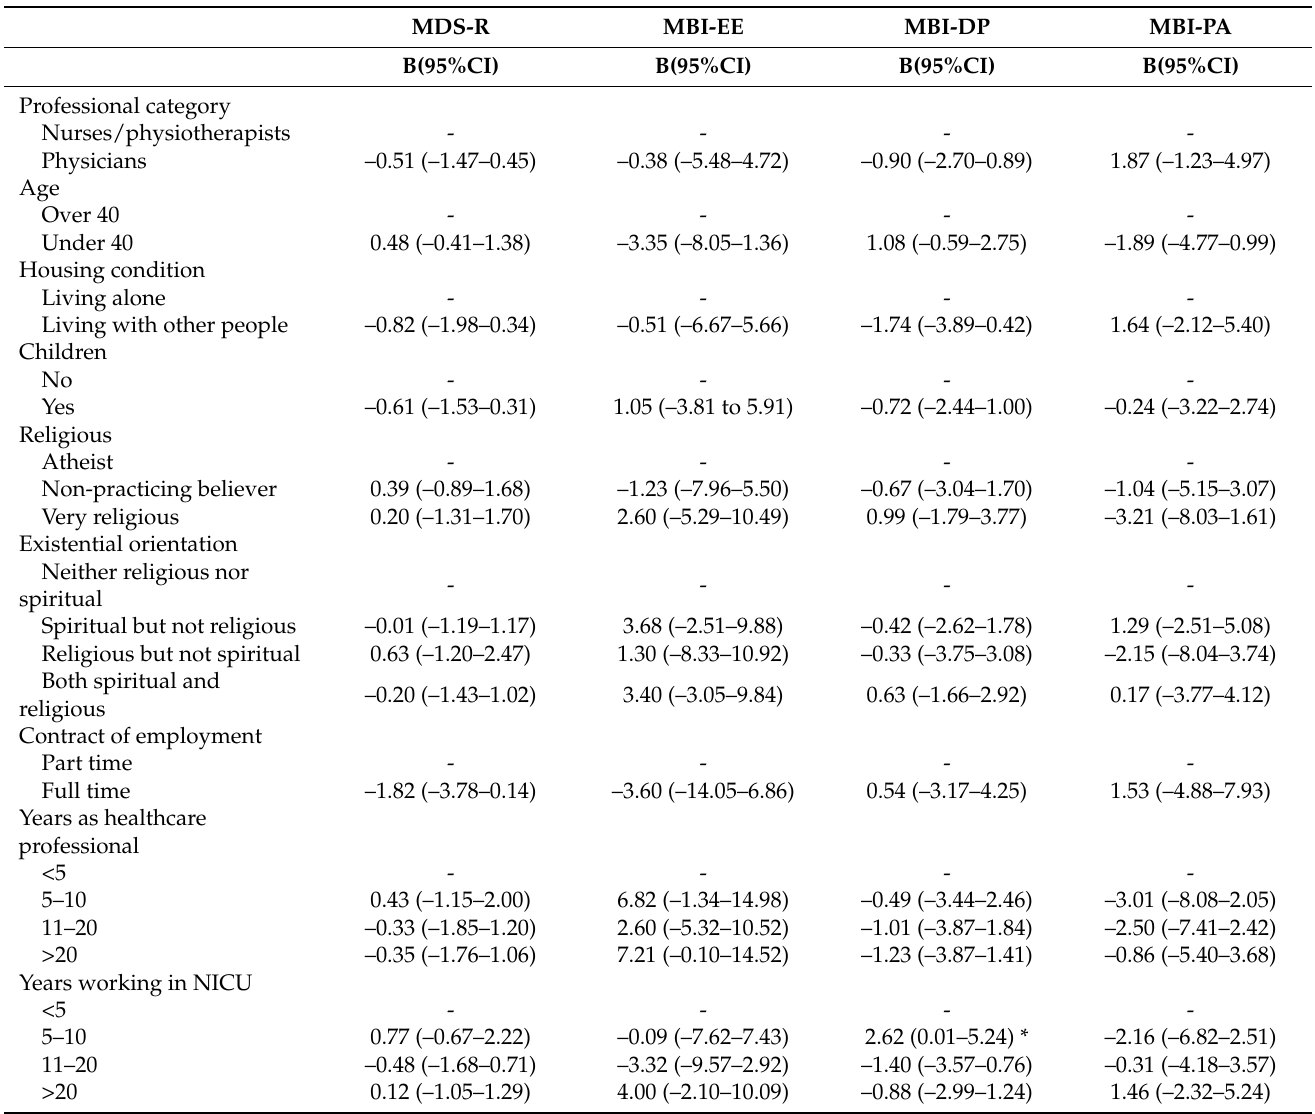
Table 3. Associations between sociodemographic variables, professional experience and spirituality with MDS and MBI